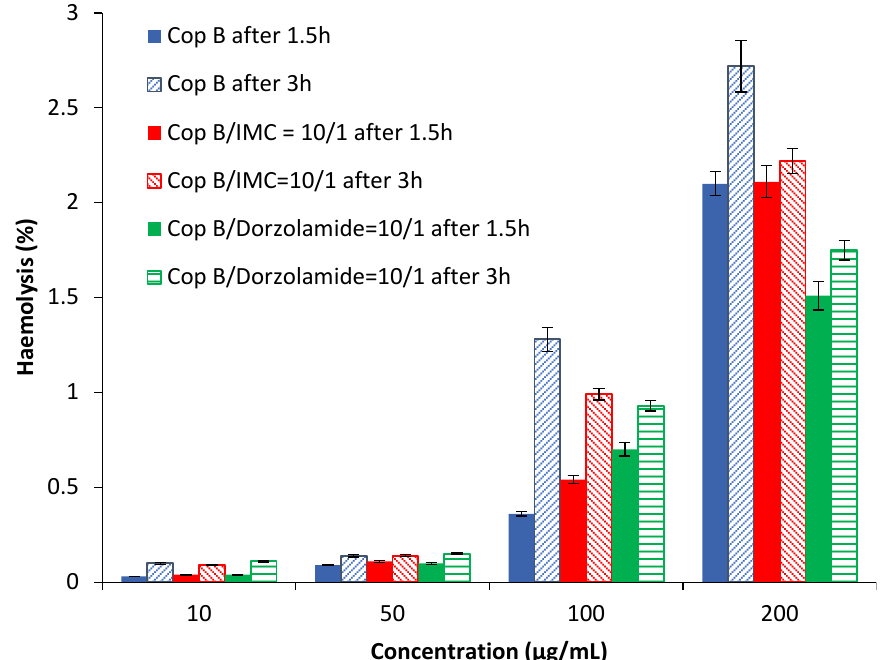
Figure 4. Haemolysis degree as a function of the PM concentration.